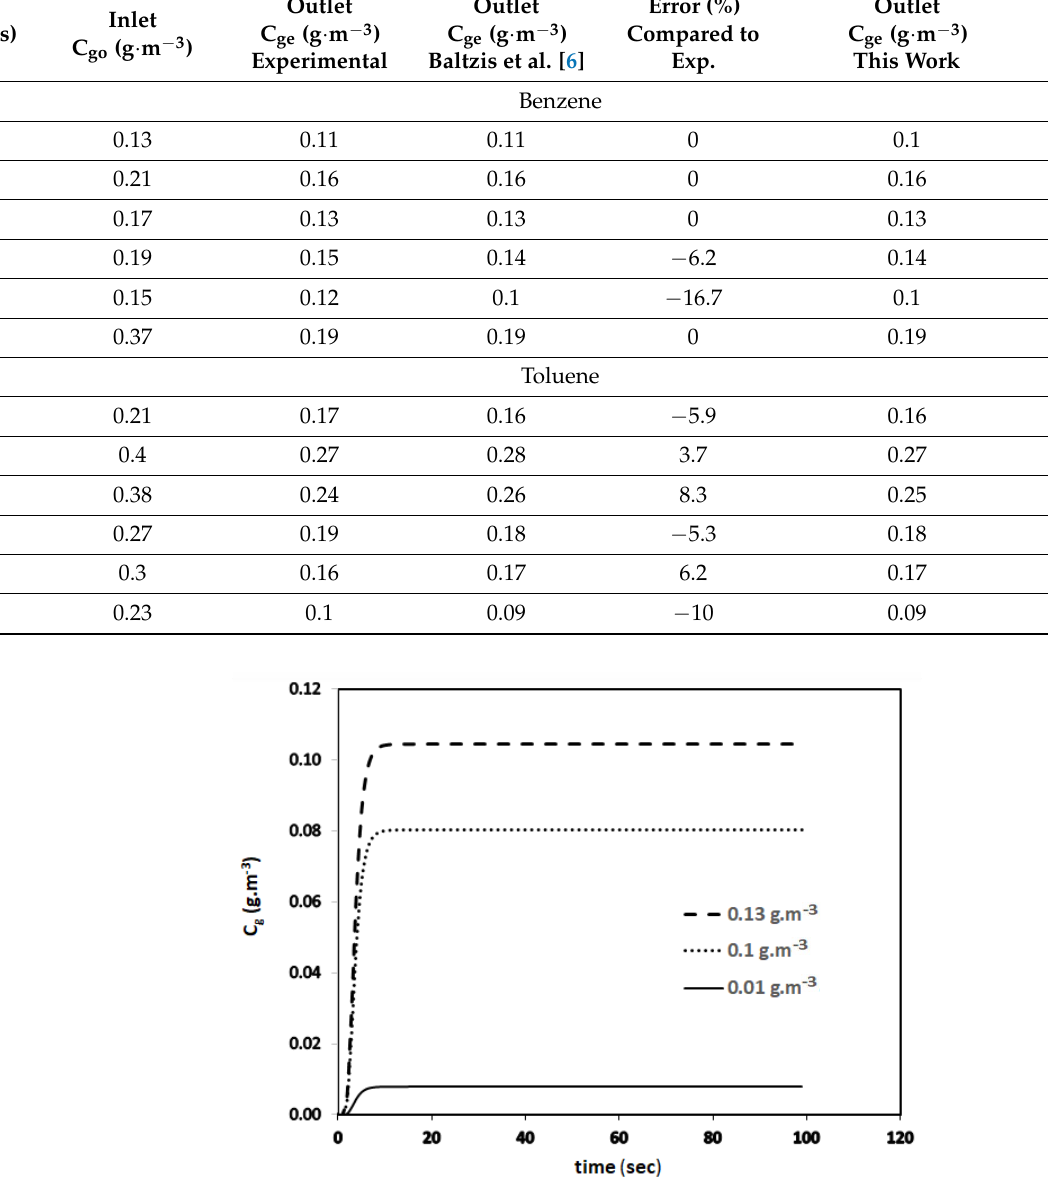
Figure 3. Transient concentration profiles predicated by the new model.